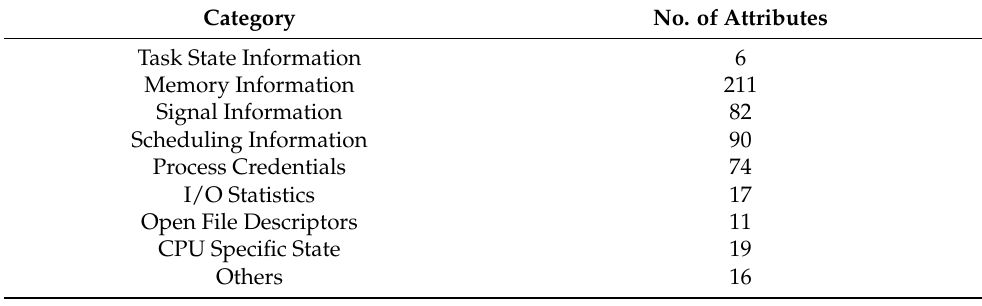
Table 2. Number of extracted features against each category of the kernel task structure.